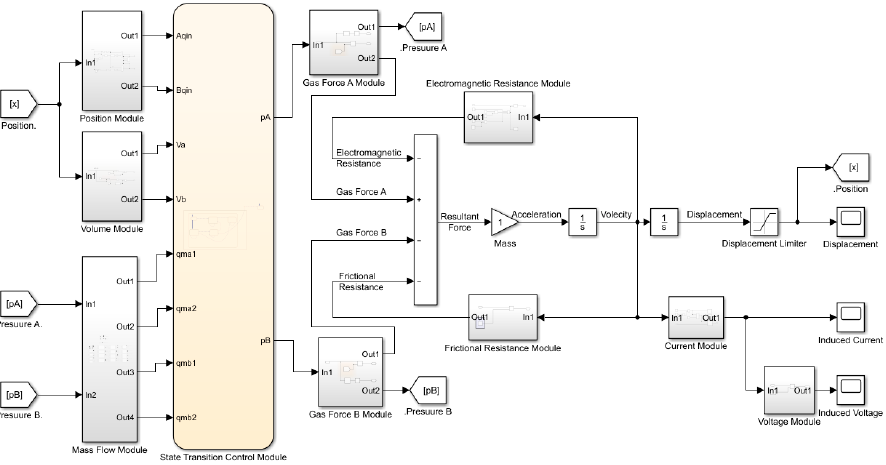
Figure 4. The model of single–piston